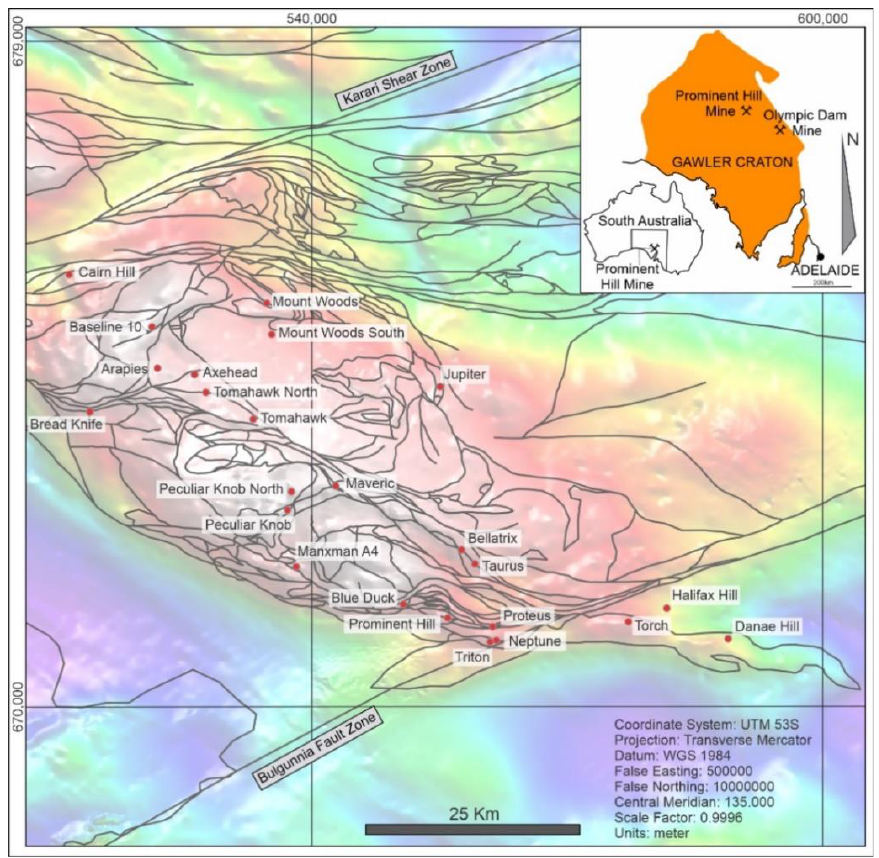
Figure 1. Overview of the Mt. Woods Inlier illustrating the locations of prospects and deposits across the region. The base map is total gravity, which highlights a sigmoidal zone between two ENE-